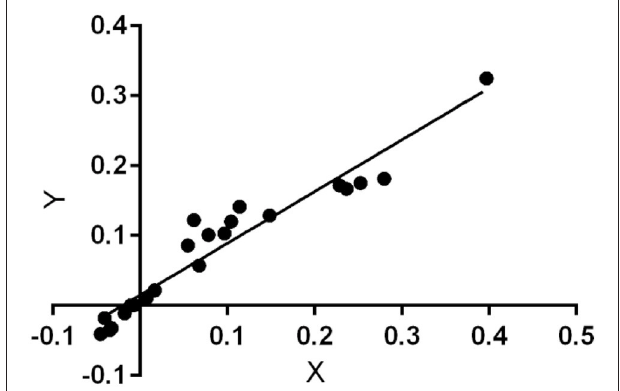
FIGURE 3 | In this figure, we regressed the divergence of freedom from a military distribution with the divergence of corruption from a military distribution. The result indicates a significant regression ( R 2 0.926, p < 0.0001). The = nations used in this regression are listed in section Materials and Methods.